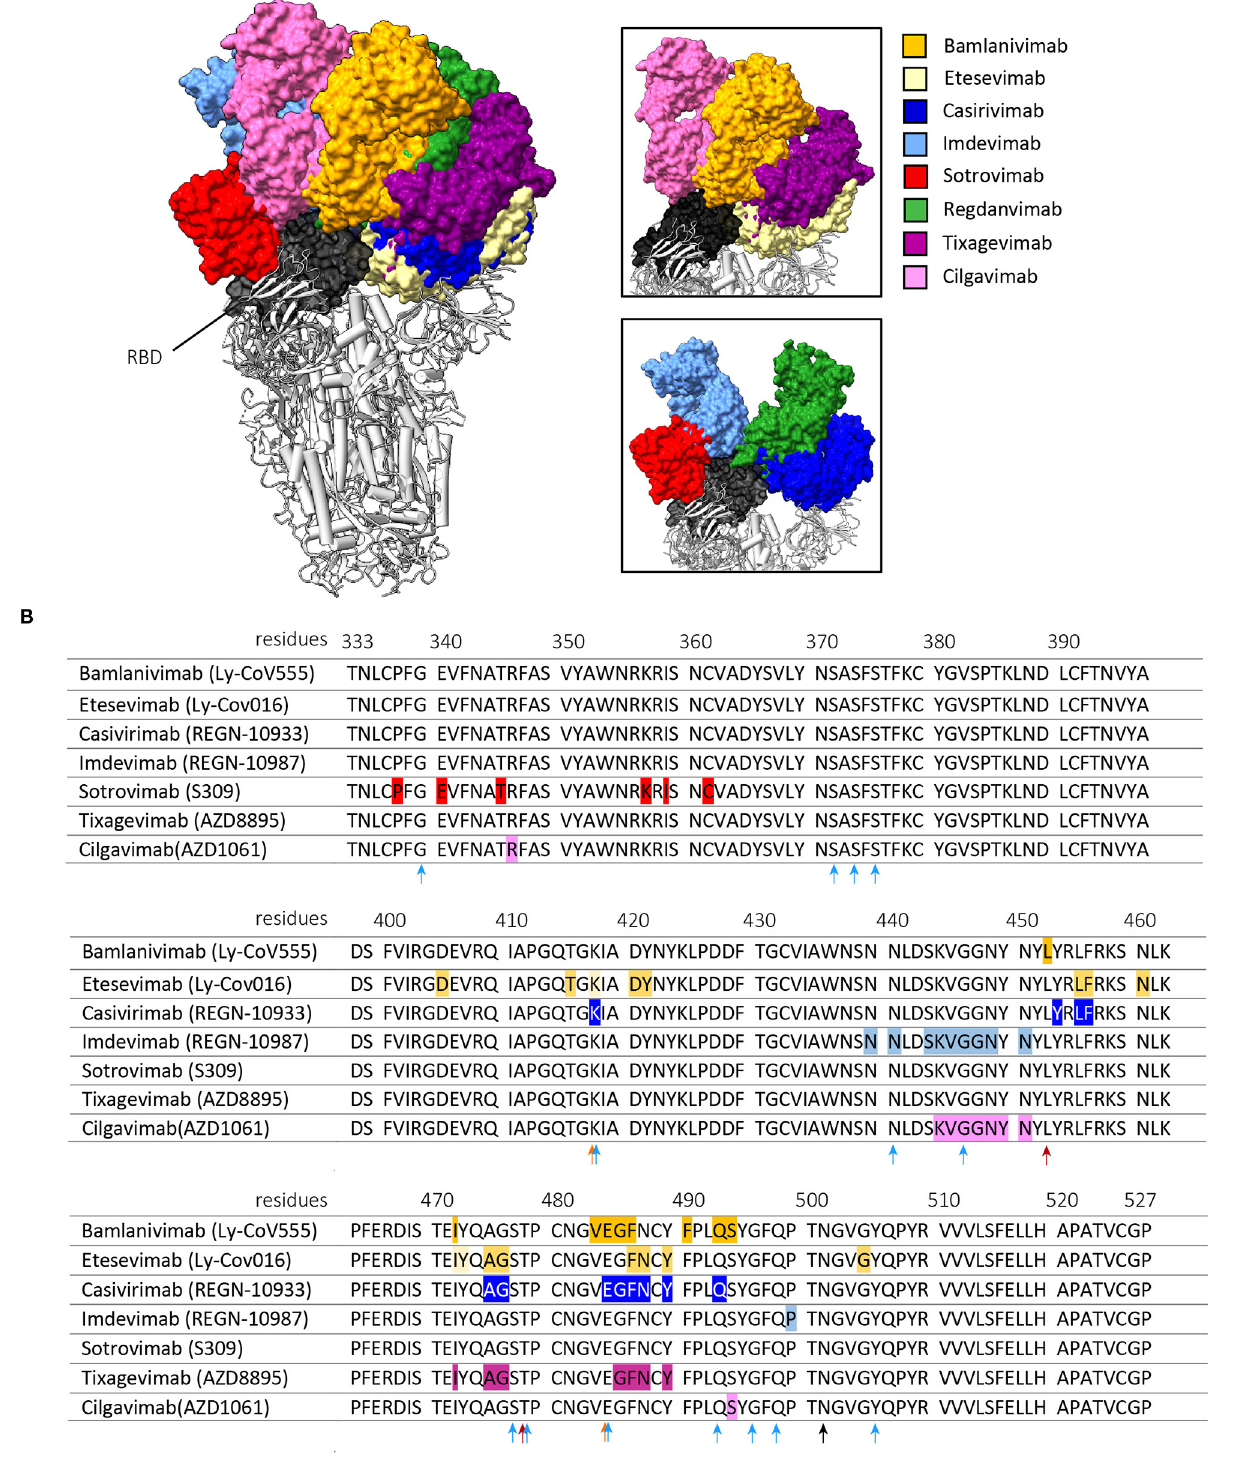
FIGURE 1 | Interaction of the clinically approved anti-SARS-CoV-2 monoclonal antibodies with the RBD of the SARS-CoV-2S protein. (A) shows the binding of the Fragment antigen-binding regions (Fabs regions) of bamlanivimab (PDB: 7KMG), etesevimab (PDB: 7C01) casirivimab (PDB: 6XDG), imdevimab (PDB: